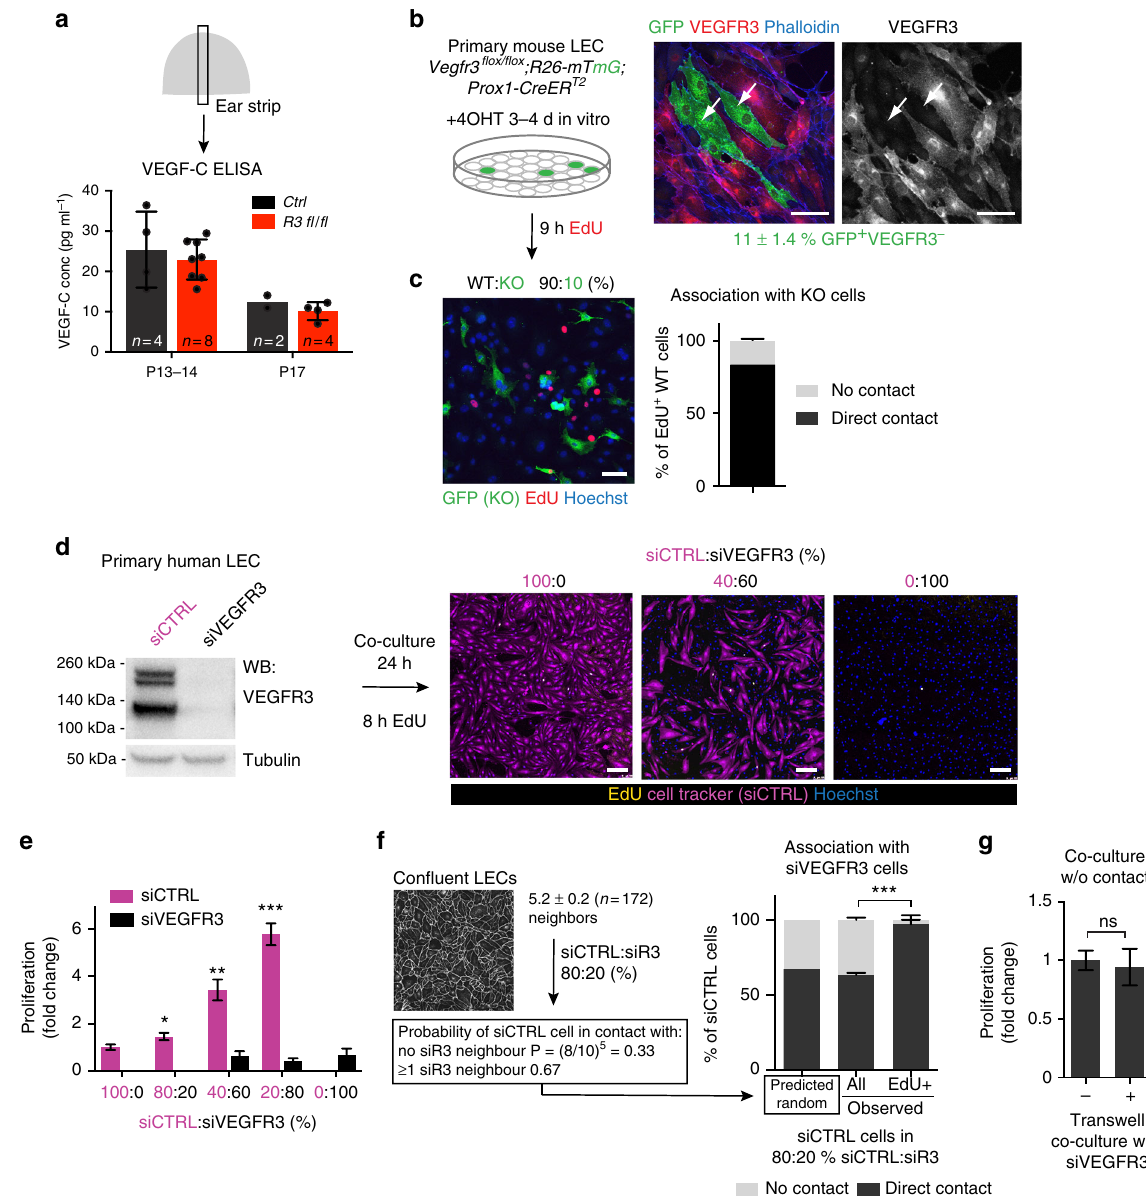
Fig. 5 Vegfr3 -deleted LECs induce proliferation of neighboring VEGFR3 + cells in a cell-contact-dependent manner. a VEGF-C concentration measured by ELISA in the ear skin at indicated stages. Bars represent mean ( n = 2 – 8 mice, as indicated) ± s.d. b Experimental set up for co-cultures of WT and VEGFR3 − (KO) primary LECs from Vegfr3 fl ox/ fl ox ; R26-mTmG;Prox1-CreER T2 mice (left) and immuno fl uorescence showing VEGFR3 depletion in Cre − targeted (GFP + ) LECs (right, arrows). c Left: proliferating WT cells were frequently associated with KO cells. Right: quanti fi cation of the proportion of EdU + WT cells that were in direct contact with KO cells (mean ( n = 6 biological replicates)± s.e.m). d Assessment of cell proliferation in co-cultures of primary human LECs treated with control (siCTRL) or VEGFR3 (siVEGFR3) siRNA. Cell tracker-labeled siCTRL cells (purple) were mixed with unlabeled siVEGFR3 cells in 40:60%, or they were cultured alone. e Quanti fi cation of proliferating EdU + cells in co-cultures of siCTRL and siVEGFR3 LECs mixed in different ratios. Data are normalized to the proliferation rate (0.8 ± 0.2%) in siCTRL alone and represent mean ( n = 5 biological replicates) ± s.e.m. f Predicted and observed proportions of siCTRL LECs (all vs. EdU + ) that are in direct contact with siVEGFR3 LECs in 80:20% siCTRL:siVEGFR3 co-cultures (mean ( n = 5 biological replicates) ± s.e.m). Predicted proportion was calculated based on random distribution and n = 5 (5.2 ± 0.2, quanti fi ed from n = 172 LECs stained for VE-cadherin) neighbors. g Quanti fi cation of proliferating EdU + cells in siCTRL LECs cultured alone ( − ), or co-cultured without direct cell – cell contacts with siVEGFR3 cells seeded on Transwell inserts ( + ). Data are normalized to the proliferation rate in siCTRL alone and represent mean ( n = 6 biological replicates) ± s.e.m. * P < 0.05, ** P < 0.01, *** P < 0.001. Two-tailed unpaired Student ’ s t test ( a , e , g ) and Fisher ’ s exact test ( f ). Scale bars: 50 µ m ( b , c ), 200 µ m ( d ). ns: not signi fi Discussion Cre/loxP mediated gene deletion, that VEGFR3 is the major VEGF-C receptor during embryonic lymphangiogenesis. LEC- VEGF-C signaling through its tyrosine kinase receptors VEGFR2 speci fi c deletion of Vegfr3 in embryos led to dermal lymphatic and VEGFR3 is the key regulator of embryonic and post-natal vessel hypoplasia and revealed an indispensable function of lymphatic development 14,17,22 . Here we show, using conditional